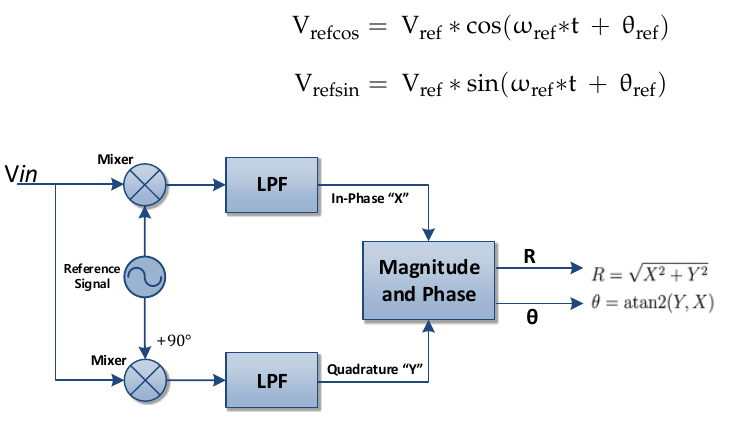
Figure 13. Block diagram for developed digital lock-in amplifier DLIA. By multiplying Equation (10) with Equations (11) and (12) we obtain Out X and Out Y as in Equation (13) and Equation (14).